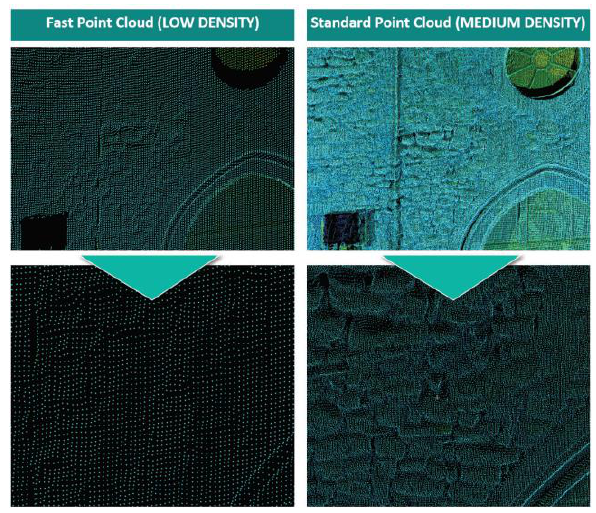
Figure 6 . Comparison between fast and standard density point cloud acquired with TLS survey.